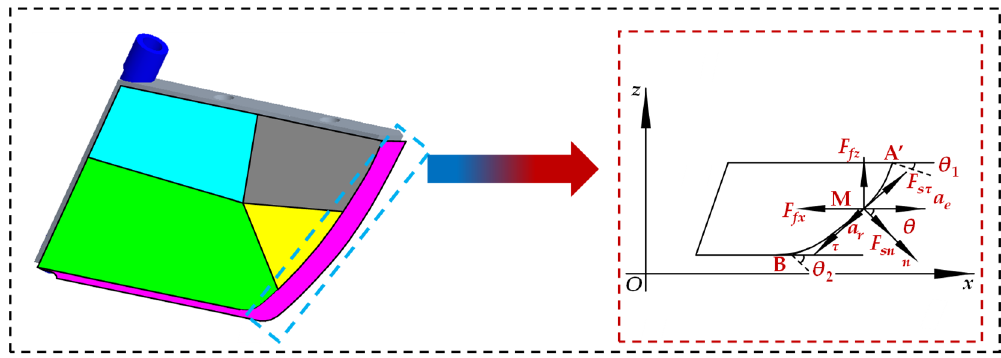
16 of 22 Figure 14. Schematic diagram of the guide inclined surface structure. Schematic diagram of the shaping surface structure and soil particle kinematics analyses. ( a ) Schematic diagram of the dis- turbed soil surface structure. ( b ) Force analysis on the yOz plane. ( c ) Force analysis on the xOy plane.